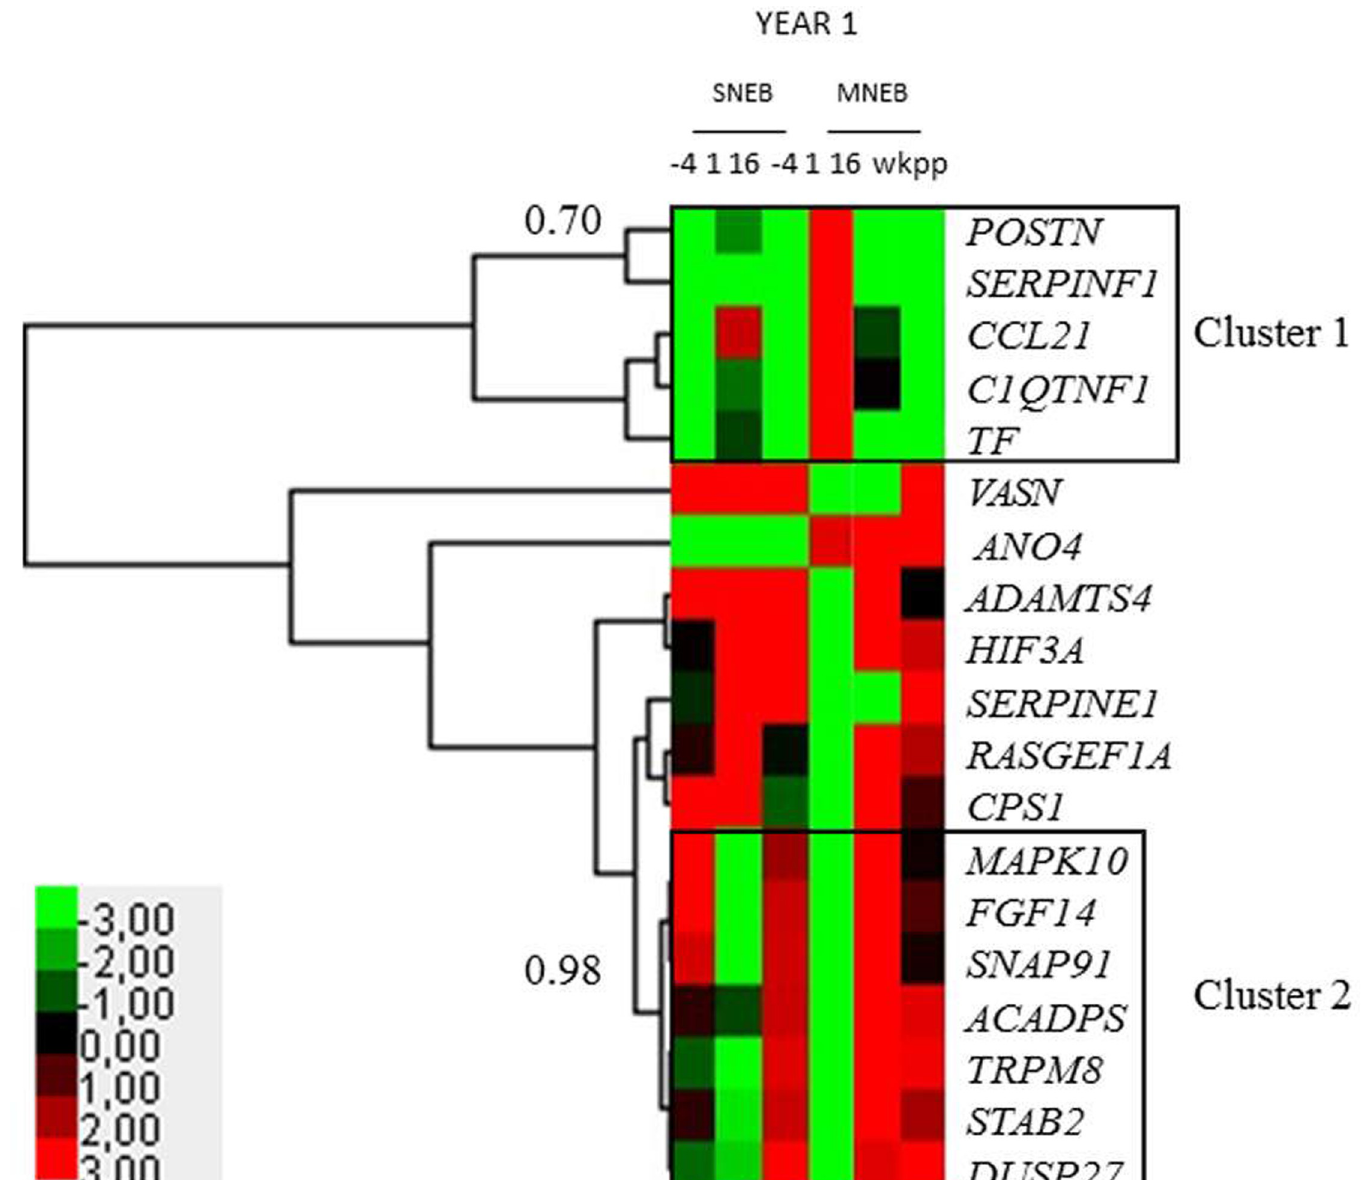
Fig 5. Clustering of candidate genes in adipose tissue of cows either with severe (SNEB) or moderate (MNEB) negative energy balance. Quantitative RT-PCR analysis was performed on subcutaneous adipose tissue samples collected at -4, 1 and 16 wkpp (n = 7 SNEB, n = 7 MNEB). Clustering of genes was performed using Cluster 3.0 software. Two clusters stand out, and node correlation thresholds are indicated for each